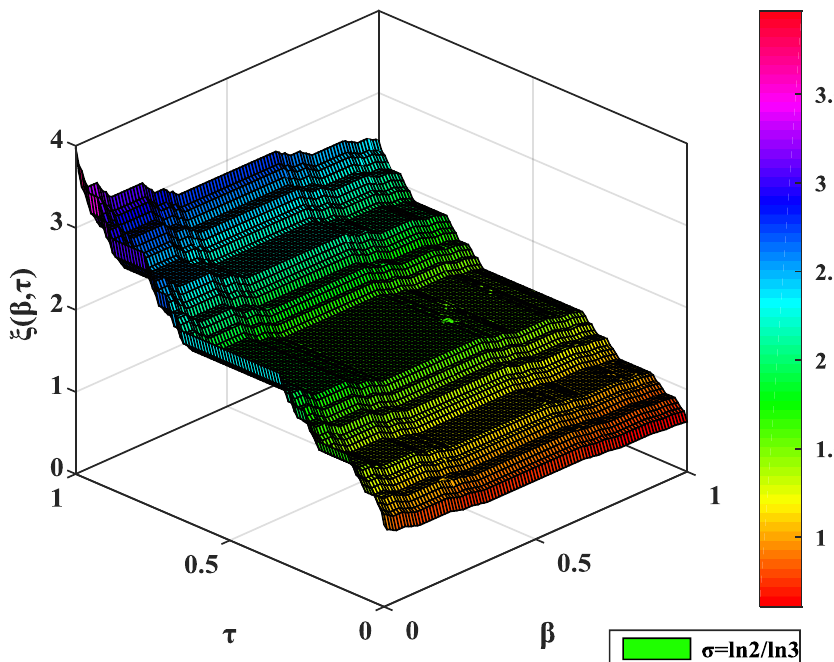
Figure 1. 3D plot of ξ ( β , τ ) w.r.t. β and τ in case of Example 1 for σ = ln2/ ln3. Fig. 1 : 3D plot of    , w.r.t.  and  in case of Example 1 for 3ln/2ln 